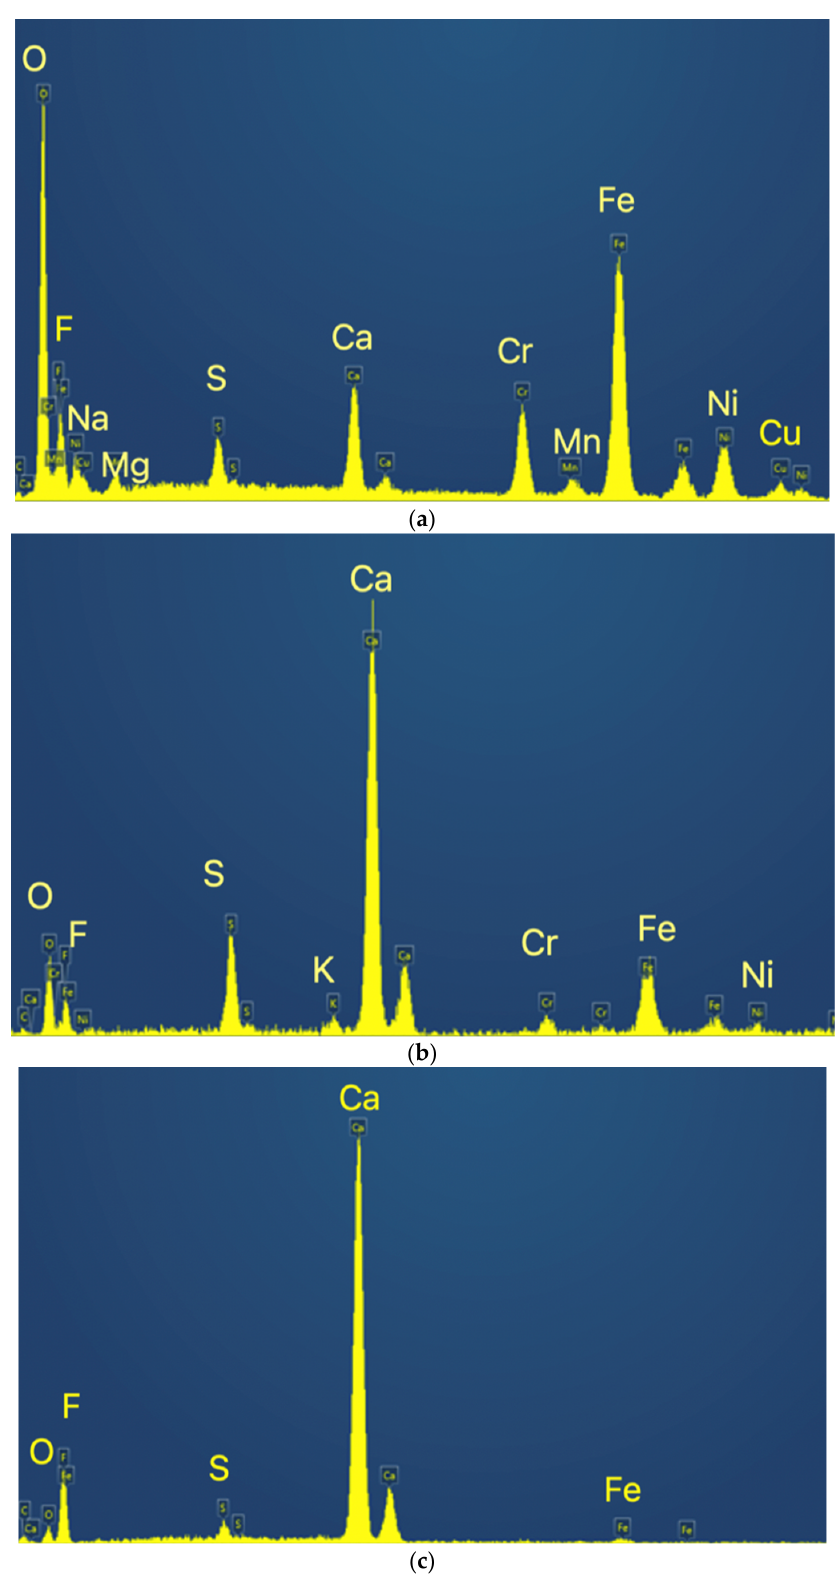
Figure 7. General view of the sample calcined at 1000 °C.